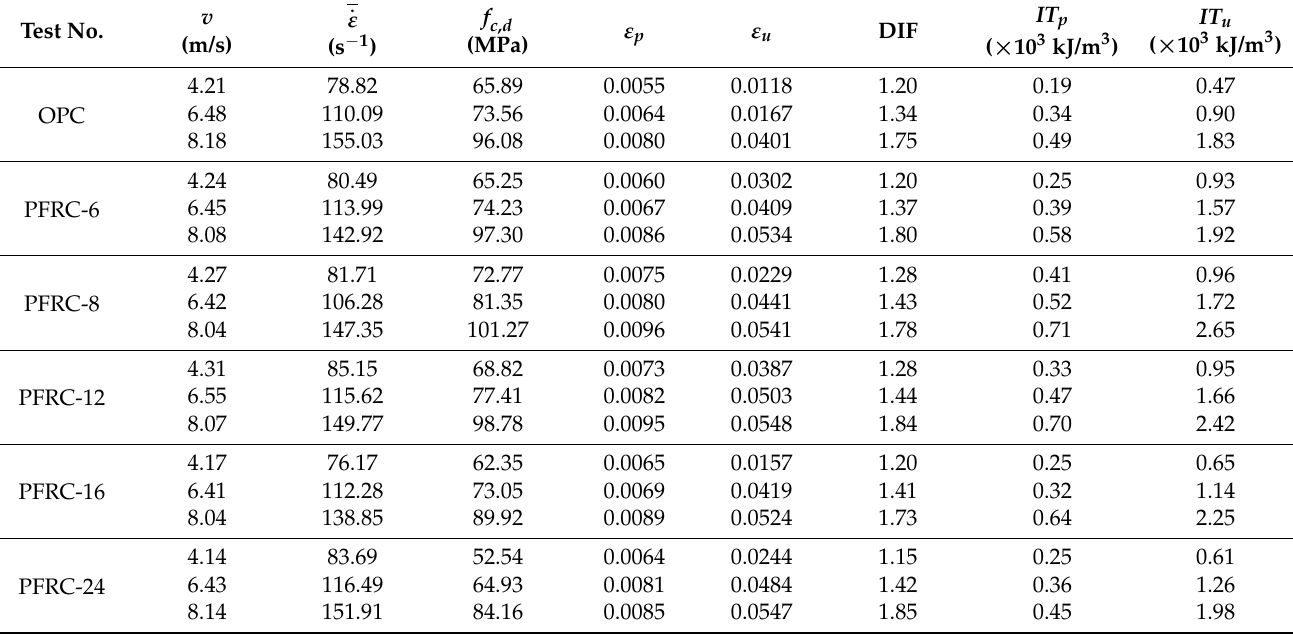
Table 7. Dynamic compression properties of OPC and